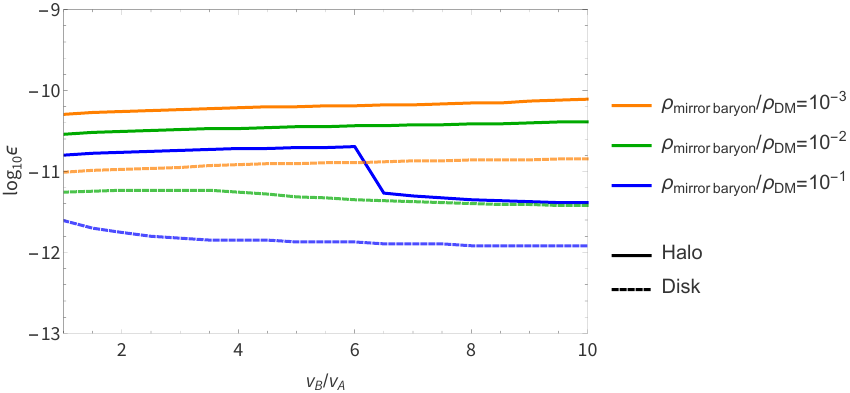
Figure 7 . White dwarf cooling constraints on mirror photon kinetic mixing in the asymmetrically reheated Mirror Twin Higgs model as a function of the parameter v VEVs in the hidden and visible sectors. The minimal Twin Higgs model gives a specific prediction for m and m as a function of this parameter (see section 2). The solids lines are for h v i = 220 ˜ p ˜ e km/s, while the dashed lines are for the disk-like h v i = 20 km/s